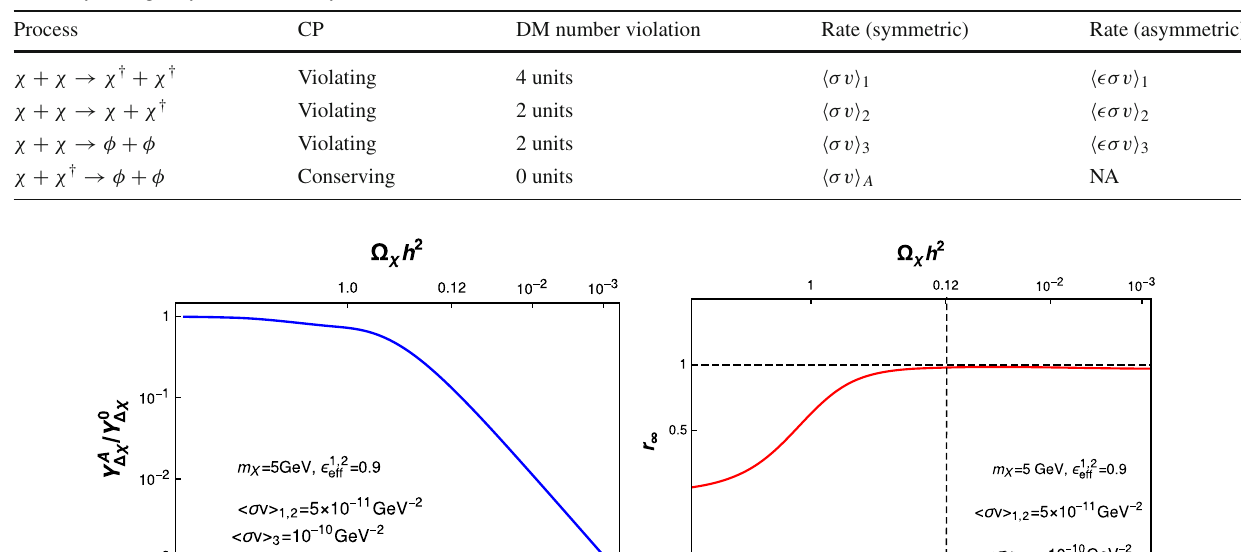
Right panel: the final particle–antiparticle asymmetry parameter r ∞ = | Y (cid:15)χ | / Y (cid:9) σv (cid:10) / (cid:9) σv (cid:10) S , as a function of A 3 . See text for details. Both the figures are for the asymmetric DM model from scattering discussed in Sect.